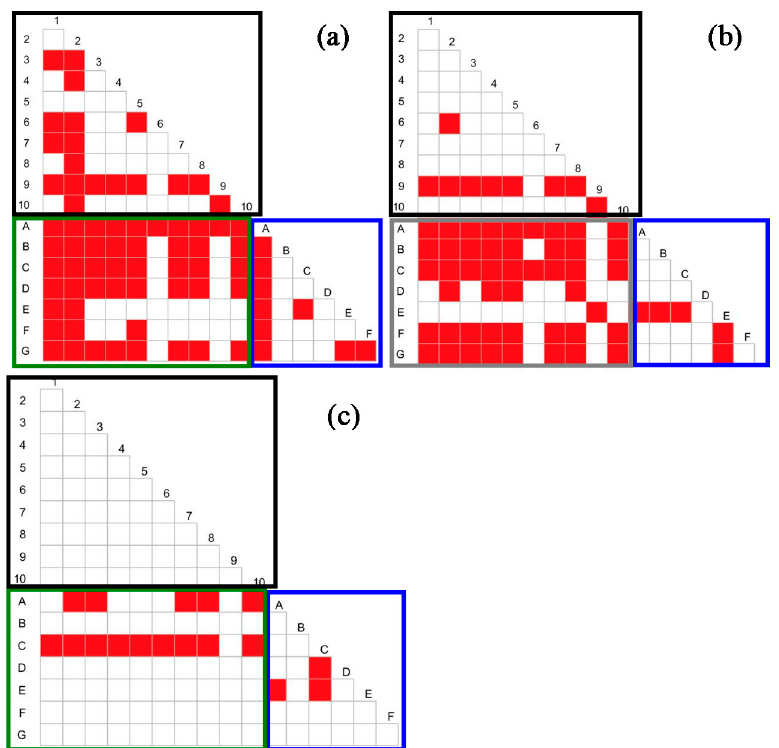
Figure 6. The pairwise comparison of mean LST differences within LCZ types in JJJ ( a ), YRD ( b ) and PRD ( c ) in summer, 2018. Red indicates that the LST difference is significant ( p < 0.05), while, white is not significant. Black squares show LST differences within LCZ 1–10, green squares show LST differences between natural surfaces (LCZ A–G) and built surfaces (LCZ 1–10), and blue squares show differences within LCZ A–G.